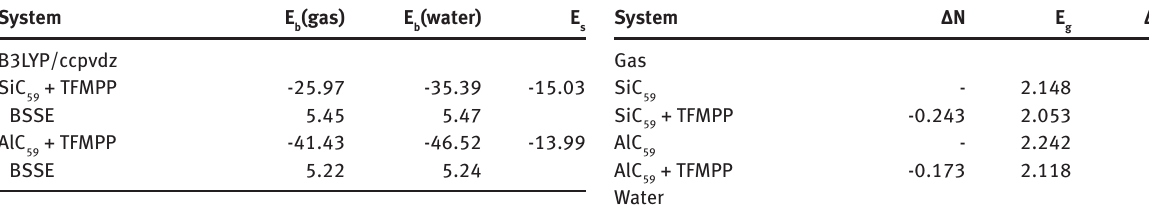
Table 2: Adsorption energy for the doped fullerenes and TFMPP interaction. System